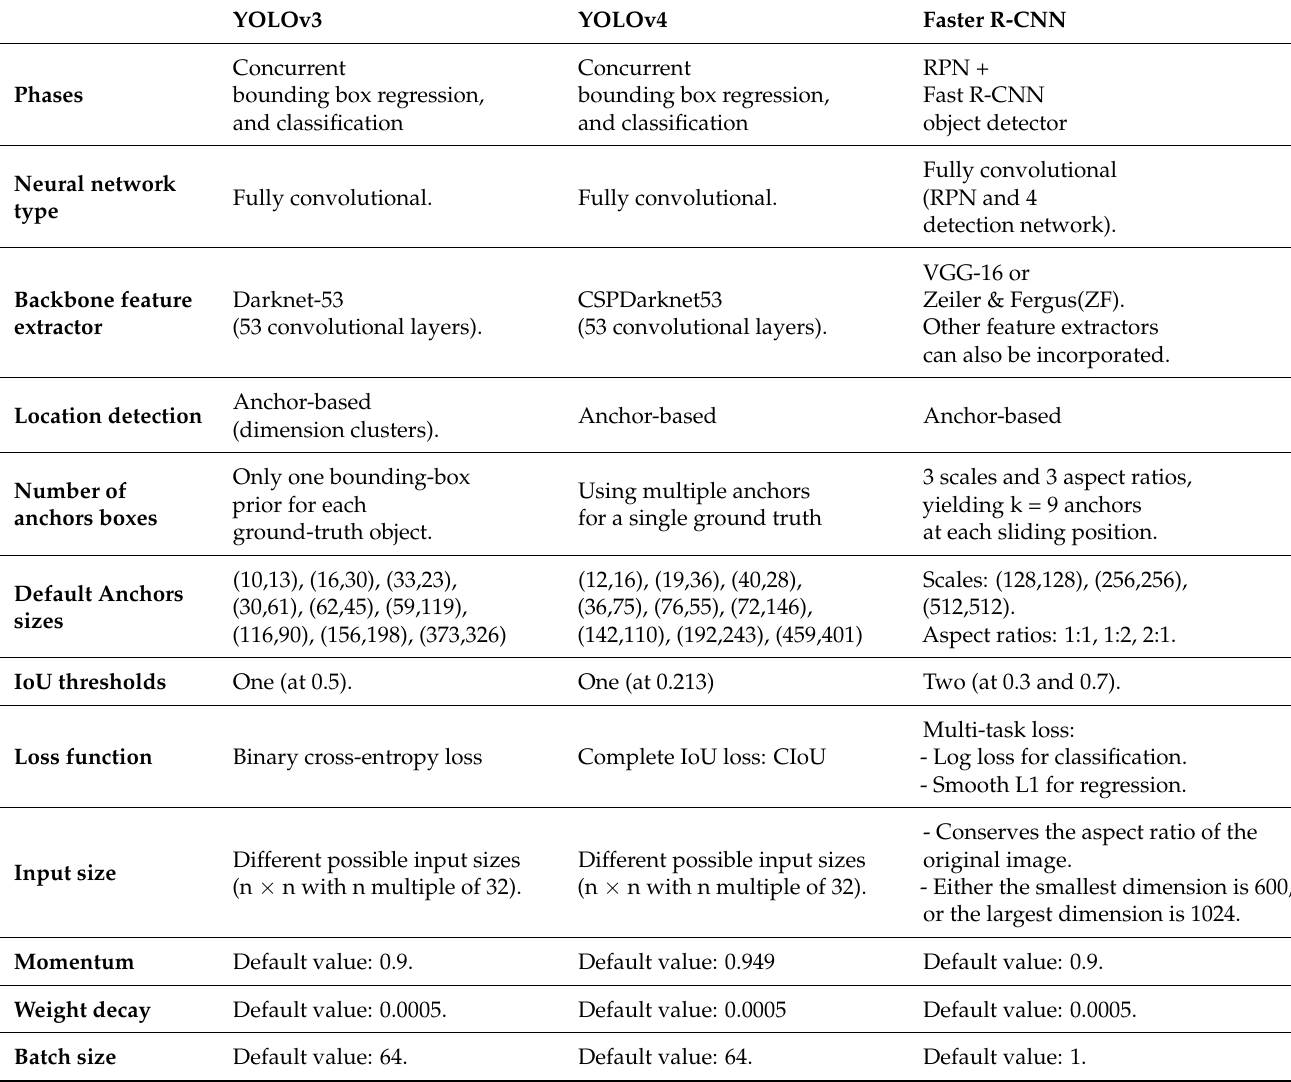
Table 2. Theoretical comparison of YOLOv3, YOLOv4, and Faster